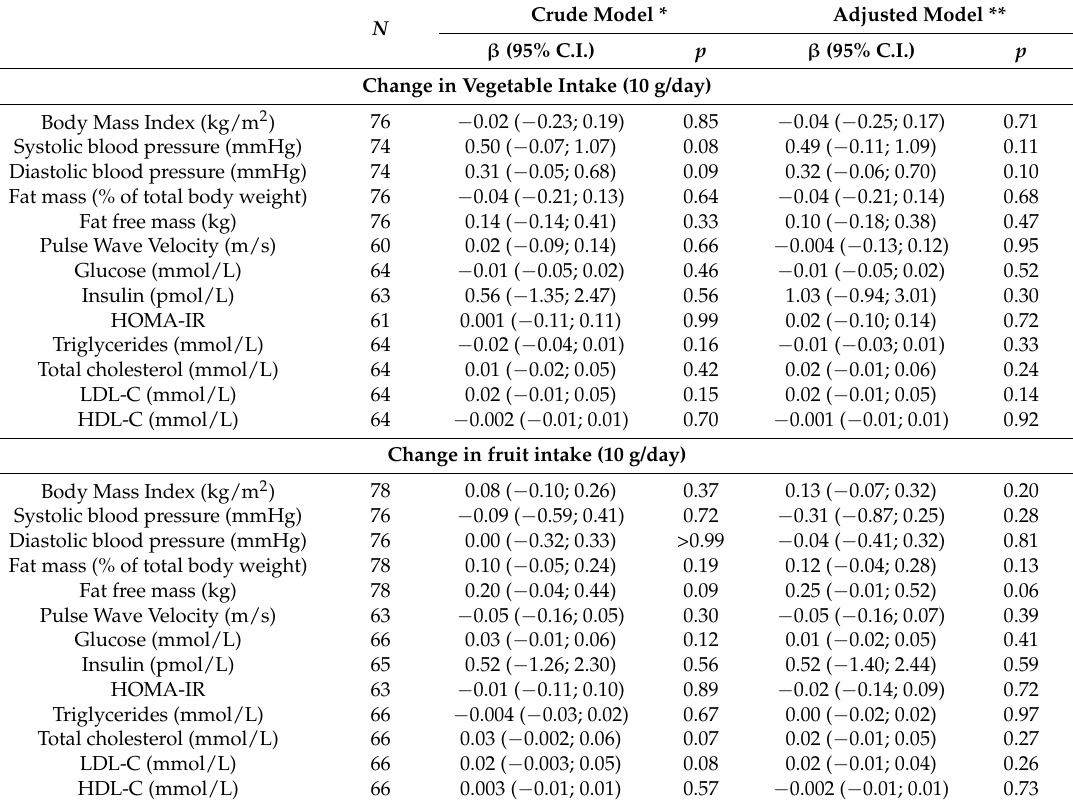
Table 3. Association between the change in dietary intake and physical activity during the preconception lifestyle intervention and cardiometabolic health 3–8 years after randomization